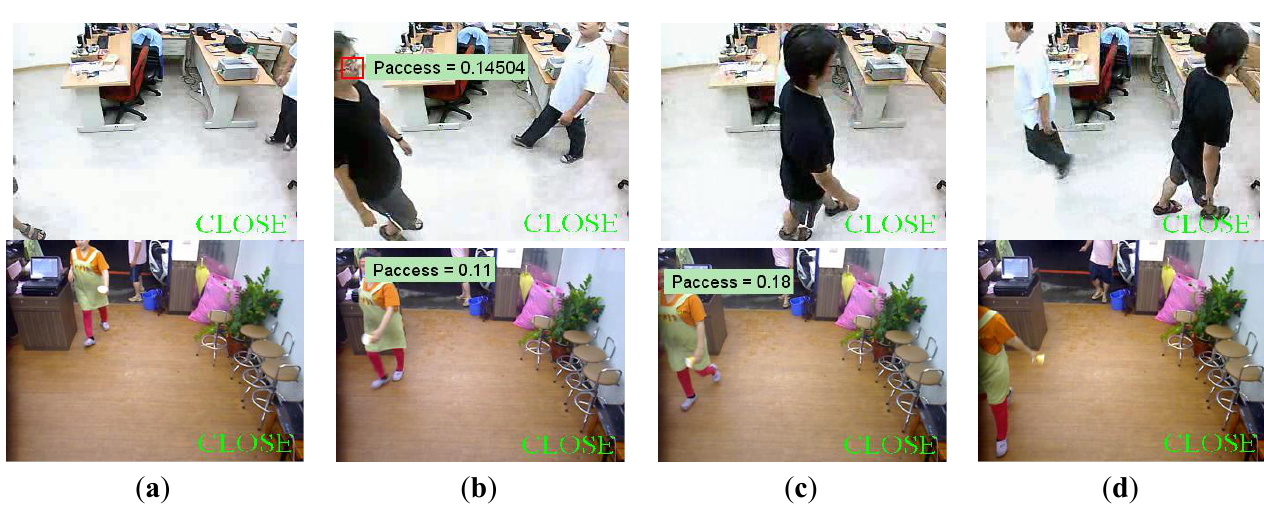
Figure 8. Illustration of “just passing by” case in lab and restaurant: It is observed that although a person is detected in ROI, the door is not opened since the person is just passing by the entrance, thus the cumulative probability does not exceed the threshold value.